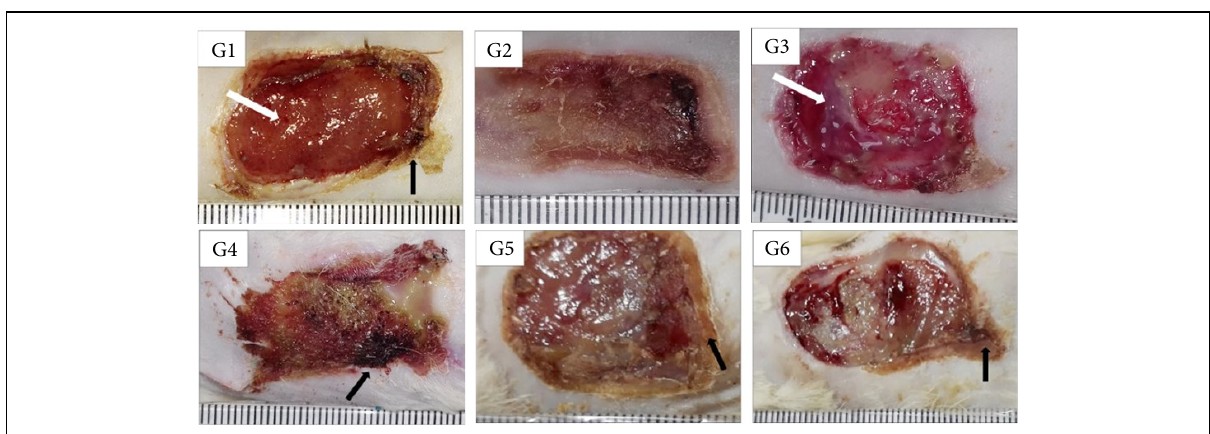
Figure 1 - Macroscopic aspects of partial thickness burn wounds experimentally induced in Wistar rats treated with silver-based dressings through 7 days.